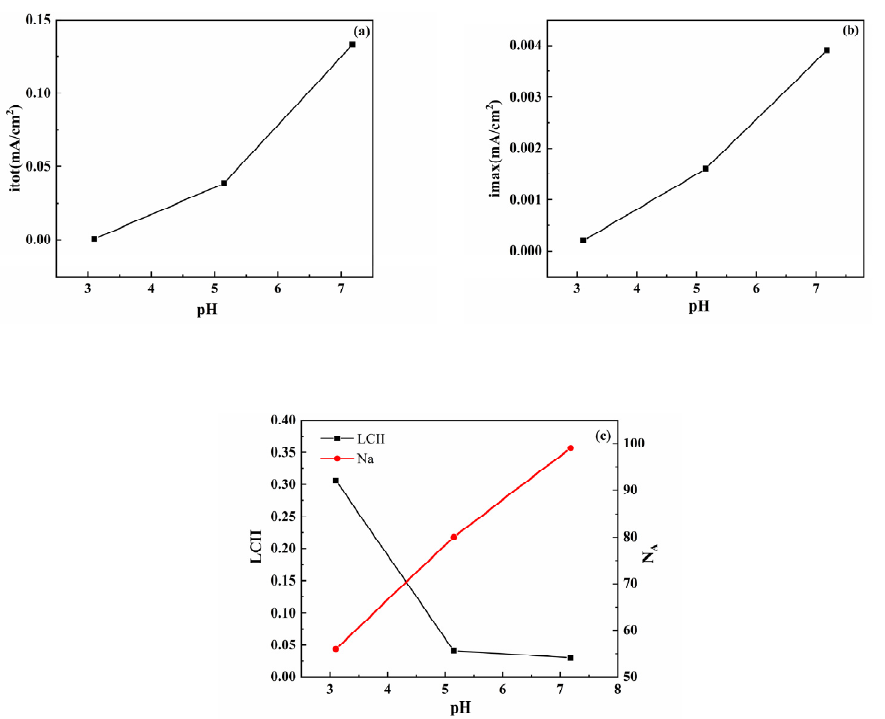
Figure 7. Optical picture of WBE at pH = 3.10: ( a ) bare electrode, ( b ) S8 − coated electrode.